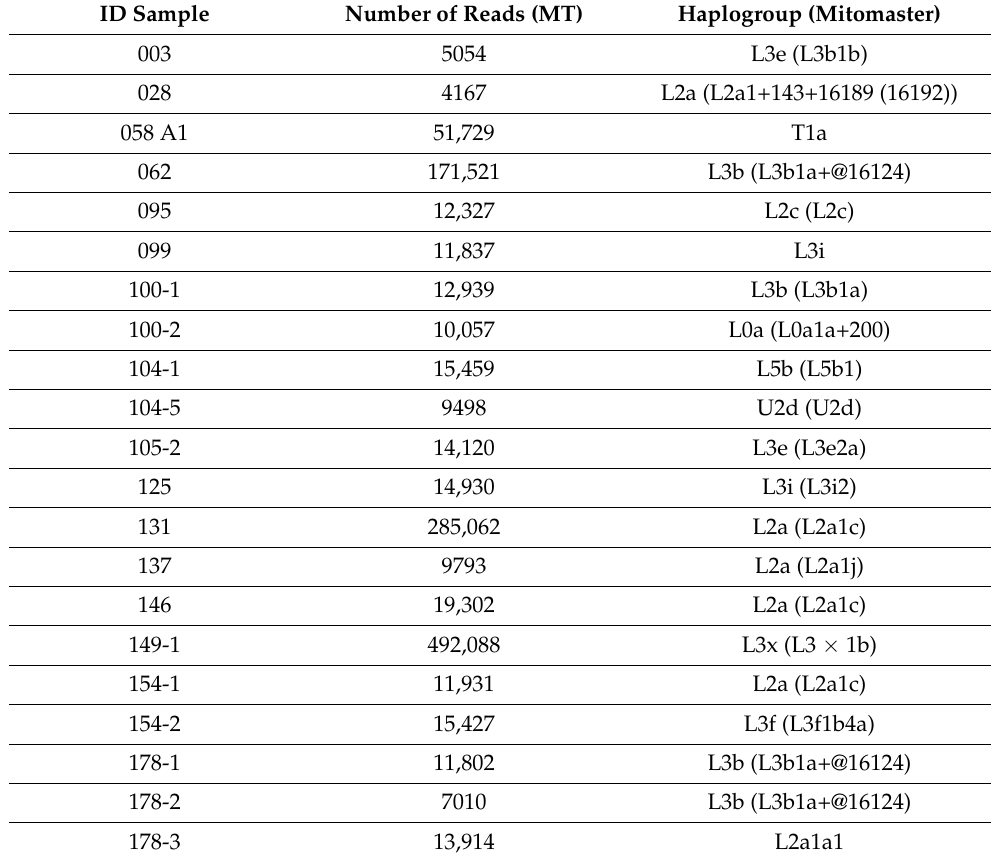
Table 5. ID sample, number of reads on mitochondrial DNA, and haplogroup assigned by the Mitomaster